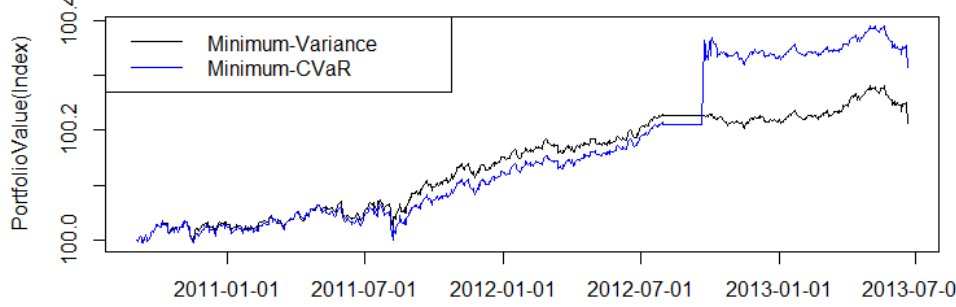
Figure 6. Trajectory of WCVaR and minimum-variance portfolio